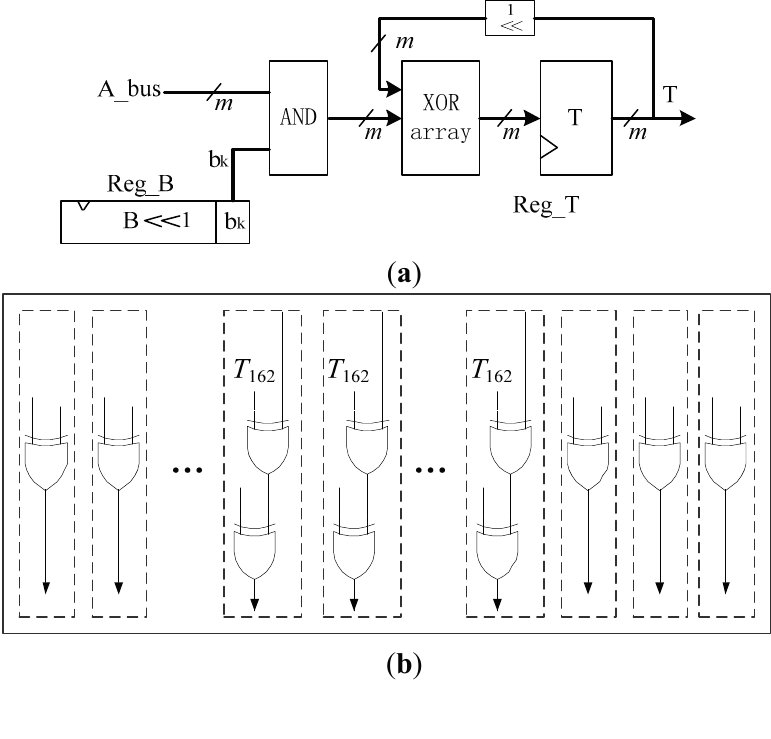
Figure 5. ( a ) The architecture of bit-serial multiplier Circuit in GF (2 163 ); ( b ) The XOR array for